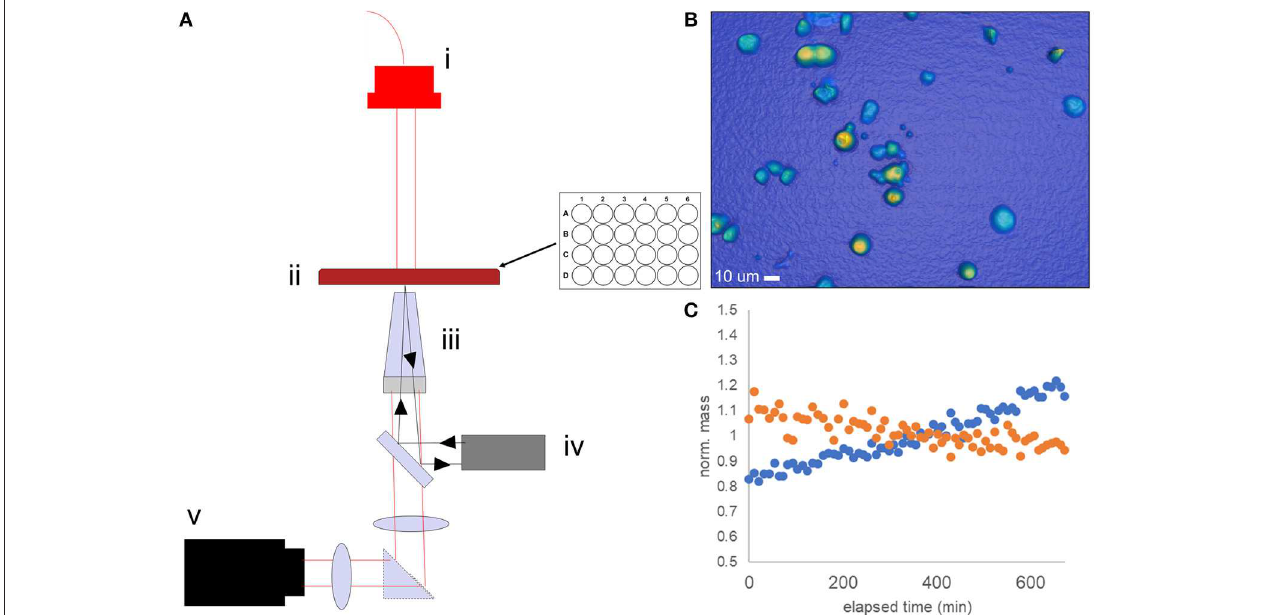
FIGURE 1 | Schematic of the HSLCI multi-well biomass accumulation assay. (A) The HSLCI system is configured with (i) fiber-coupled LED illumination source, (ii) standard footprint 24 well plate with X-Y motion controlled by motorized stages, (iii) a 40x Nikon Plan Flourite, N.A. 0.75, objective on top of piezo actuator (light gray) with focus maintained by autofocus system (iv), and (v) a wide field phase detection camera (SID4Bio, Phasics). (B) Example image of TNBC PDX cells. (C) Individual cells are tracked between images; biomass vs. time plots are generated. Shown is a typical normalized mass vs. time plot for a single drug sensitive (orange) and drug-resistant (blue)